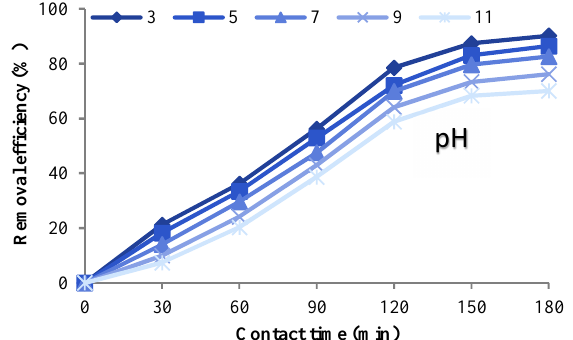
Figure 7. The effect of pH on the removal of phenol in the UV/ZnO process (the initial concentration of phenol = 40 mg/l, NaCl = 10 g/l, and radiation intensiy = 3950 µw/cm 2